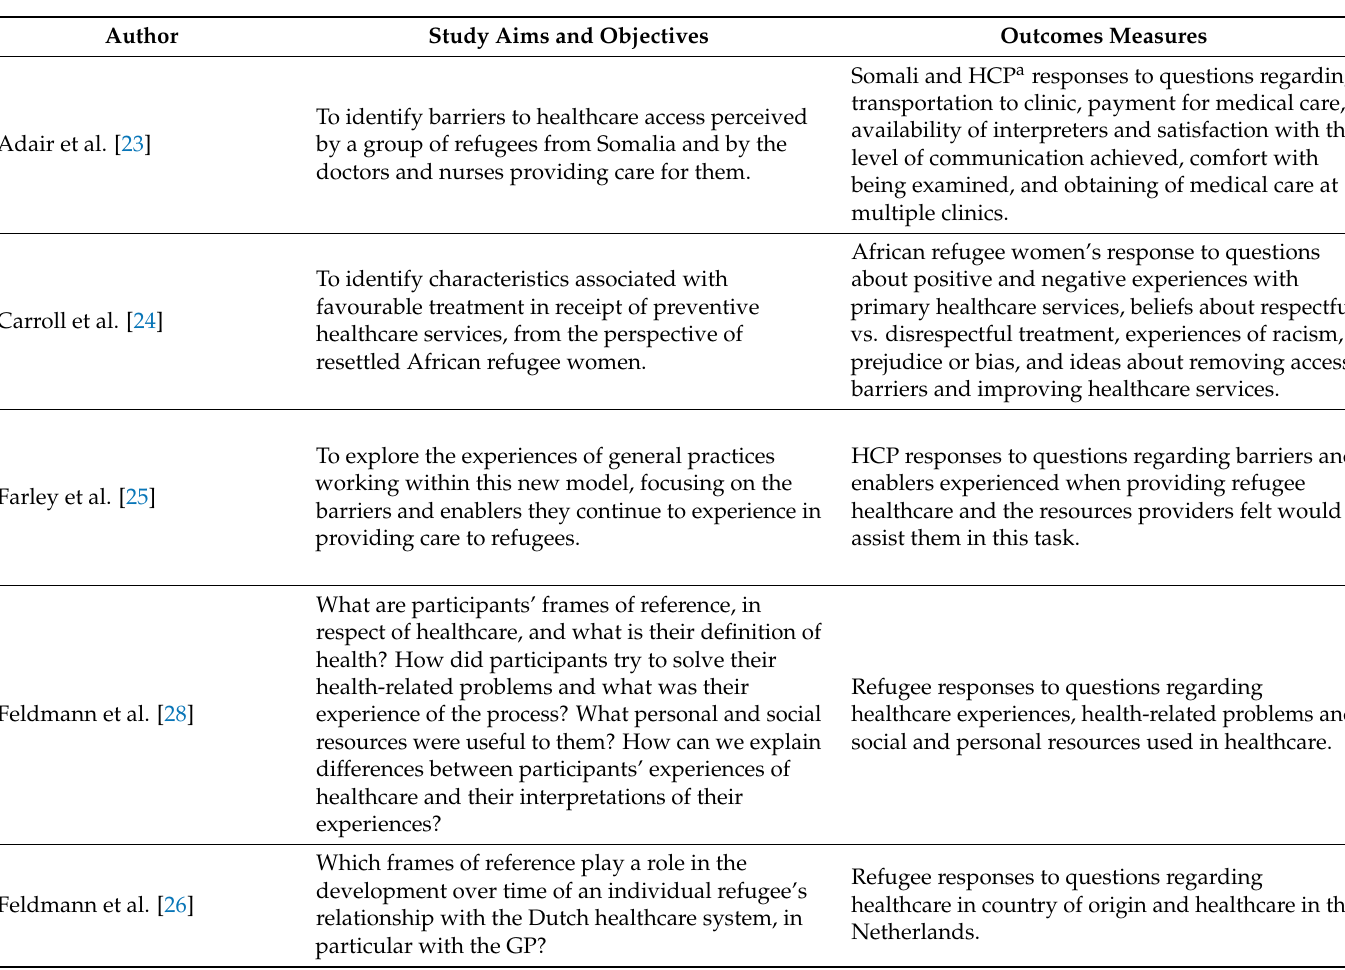
Table 2. Study aims, objectives and outcome measures of included